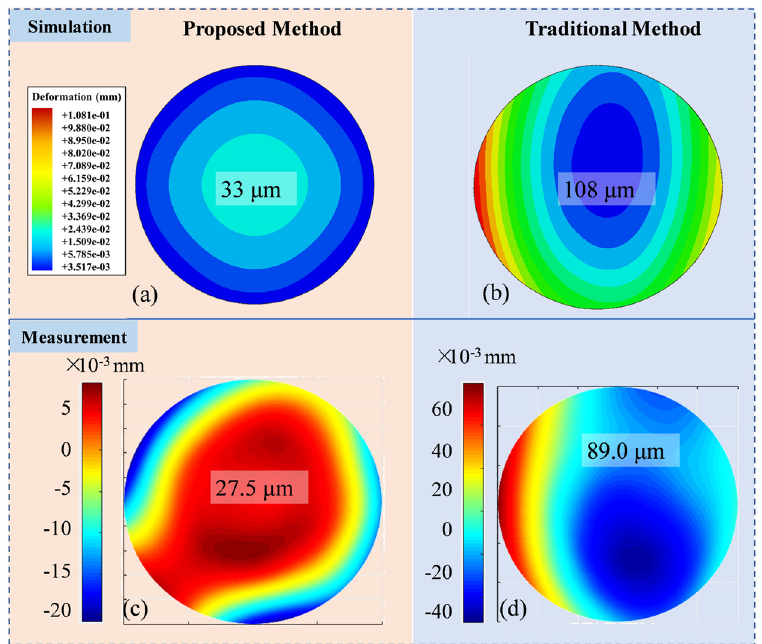
Figure 11: Part deformation by using the proposed method based on ( a ) simulation, ( c ) experimental measurement, and by using the traditional stress - relief annealing method based on ( b ) simulation and ( d ) experimental